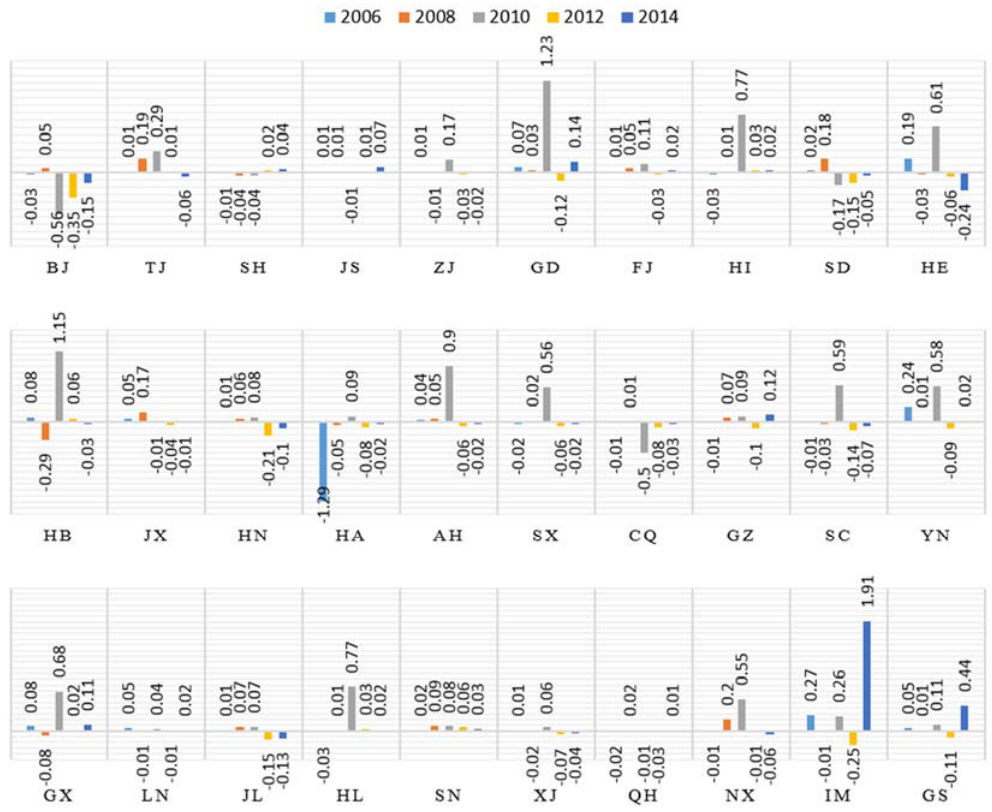
Figure 8. Contributions of direct energy proportion of 30 provinces in 2006, 2008, 2010, 2012 and 2014.